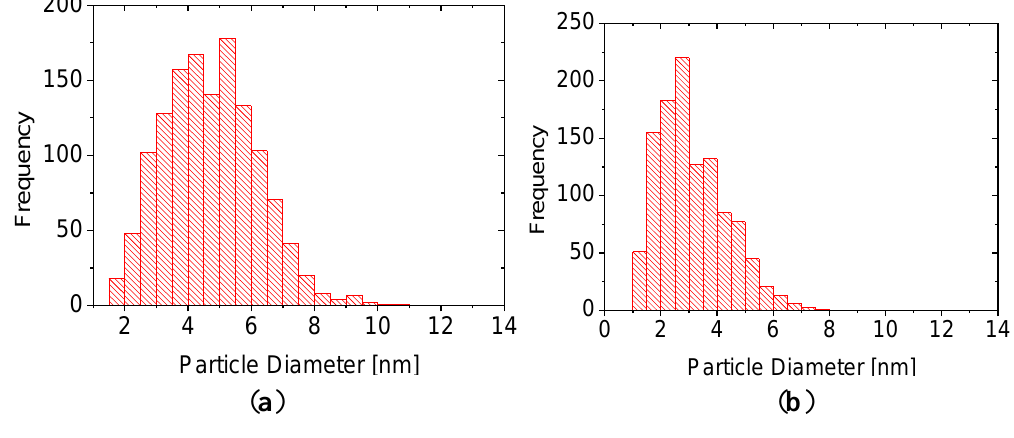
Figure 4. Particle size distribution of gold nanoparticles covered ( a ) with 1-dodecanthiol or ( b ) tert -tetradecanethiol (right panel), respectively, from transmission electron microscopy